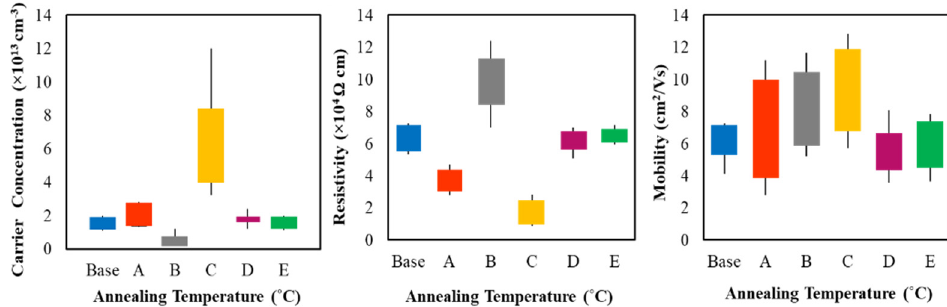
Figure 10. The Hall effect results for CdTe films before and after treatment.